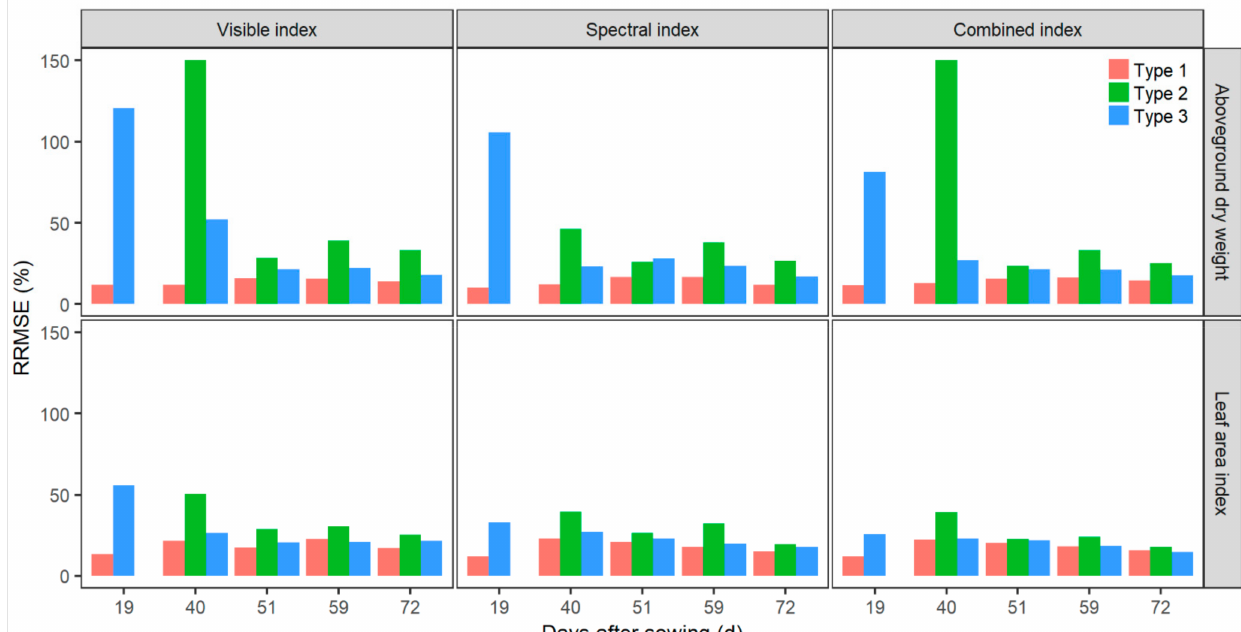
Figure 9. Comparisons of performances of PLSR models built with different modelling strategies of temporal combinations of VI datasets for estimating aboveground dry weight and leaf area index before flowering. Model performance was evaluated with the relative root mean square error (RRMSE). The three types of models included mono- (Type 1), multi- (Type 2), and full-temporal VIs (Type 3) and were built using the visible, spectral, and combined indexes,